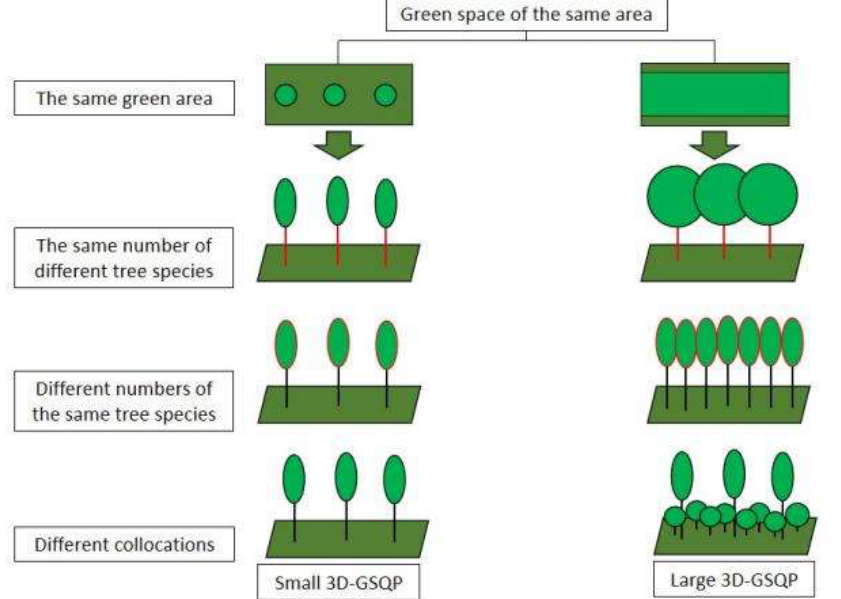
Figure 9. Different 3D-GSQP with the same green area.